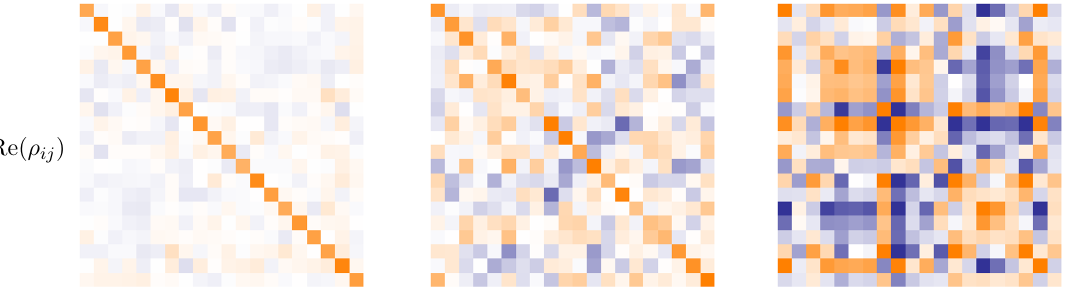
20 and e S 50 , 5 , 1 (left, middle, (cid:16) (cid:16)